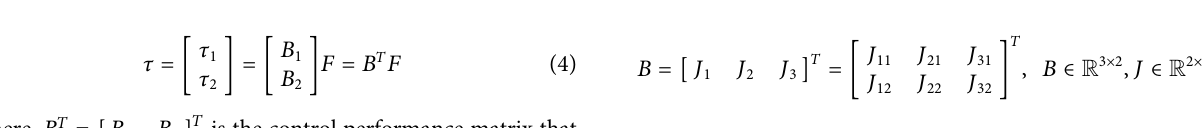
Frontiers in Bioengineering and Biotechnology |